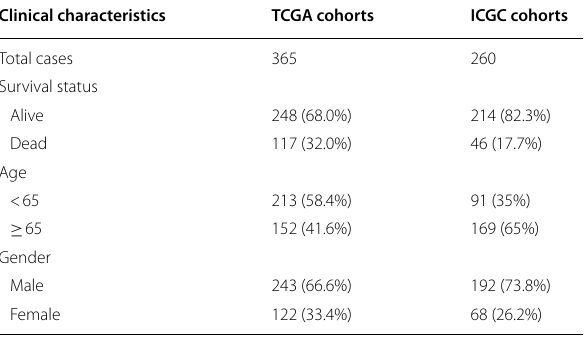
Fig. 1 Differentially expressed RBPs between HCC and normal tissues. a Heatmap of differentially expressed RBPs. b The volcano plot for the differentially expressed RBPs. Red, higher expression; green, lower expression; Black, no difference. c The expression patterns of differentially expressed RBPs. Red, tumor tissues; Green, normal tissues Table 1 Clinical characteristics of TCGA and ICGC